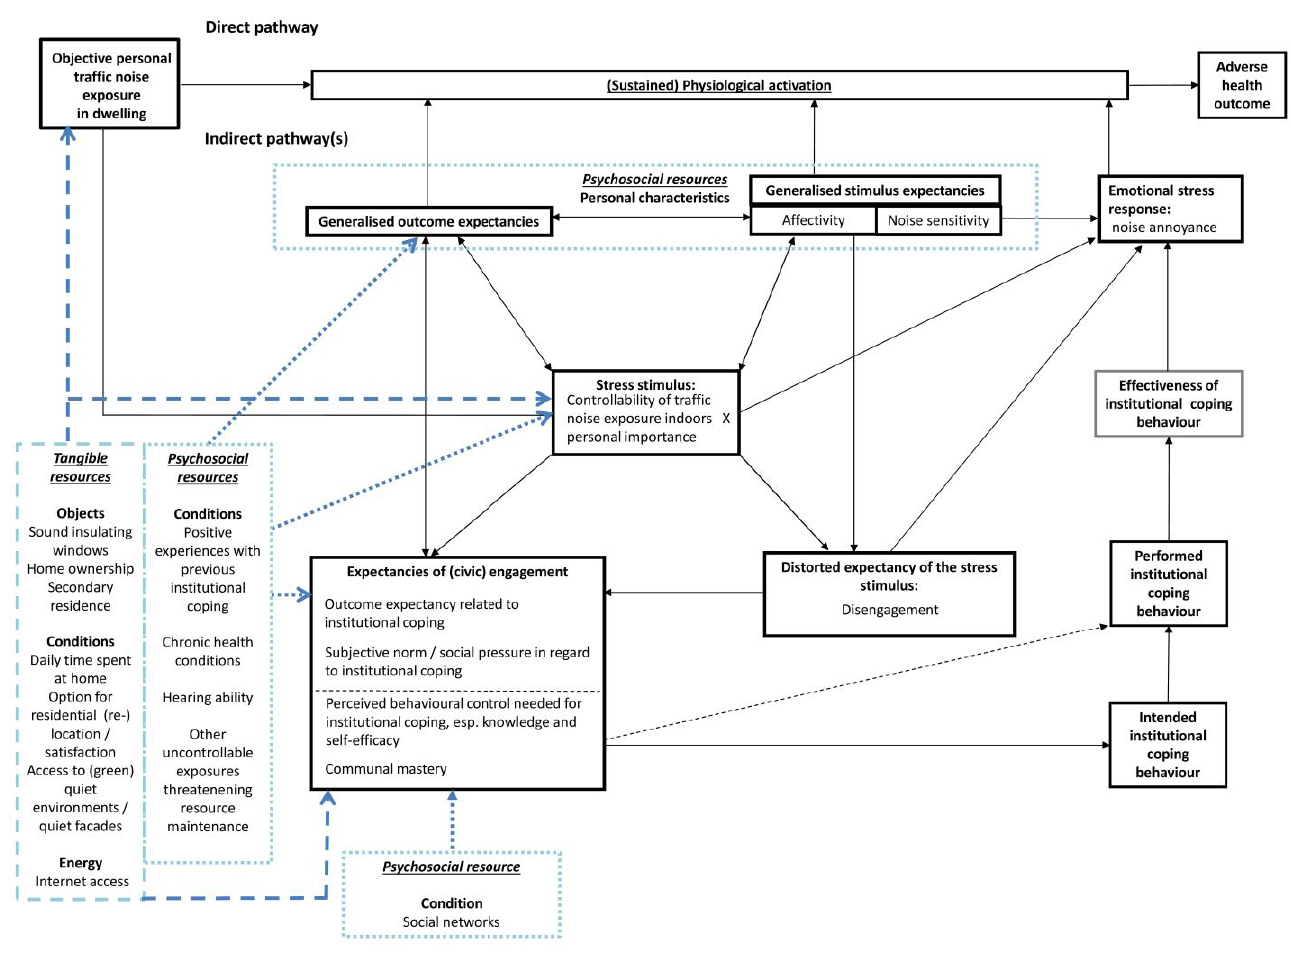
Figure 3. Adding tangible resources to our conceptual model.